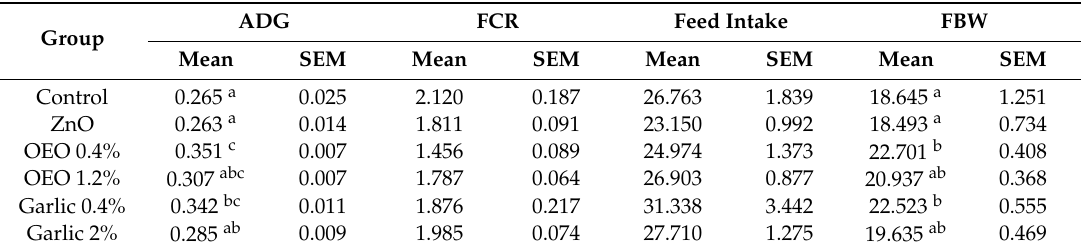
Table 5. Values of average daily gain (ADG) and feed conversion ratio (FCR) for the different groups 1,2 . ADG FCR Feed Intake FBW Group Mean SEM Mean SEM Mean SEM SEM